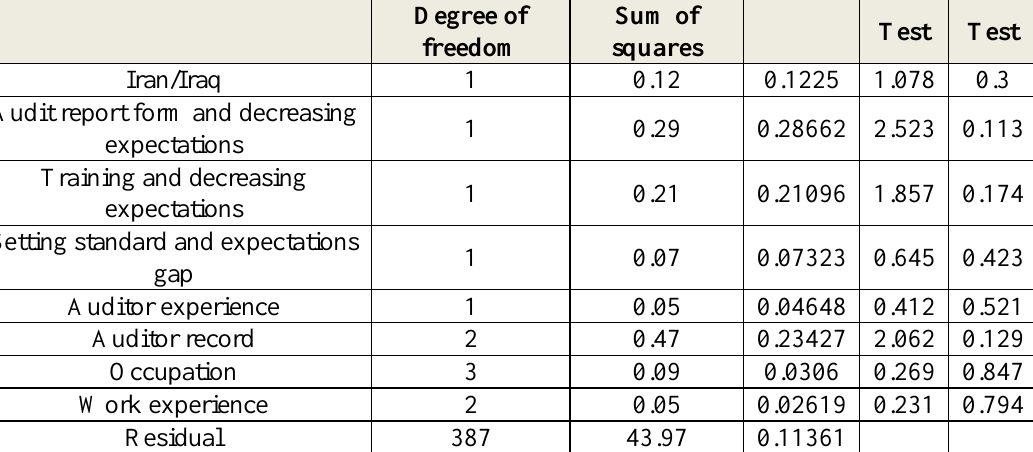
Table 11. The results of the third hypothesis